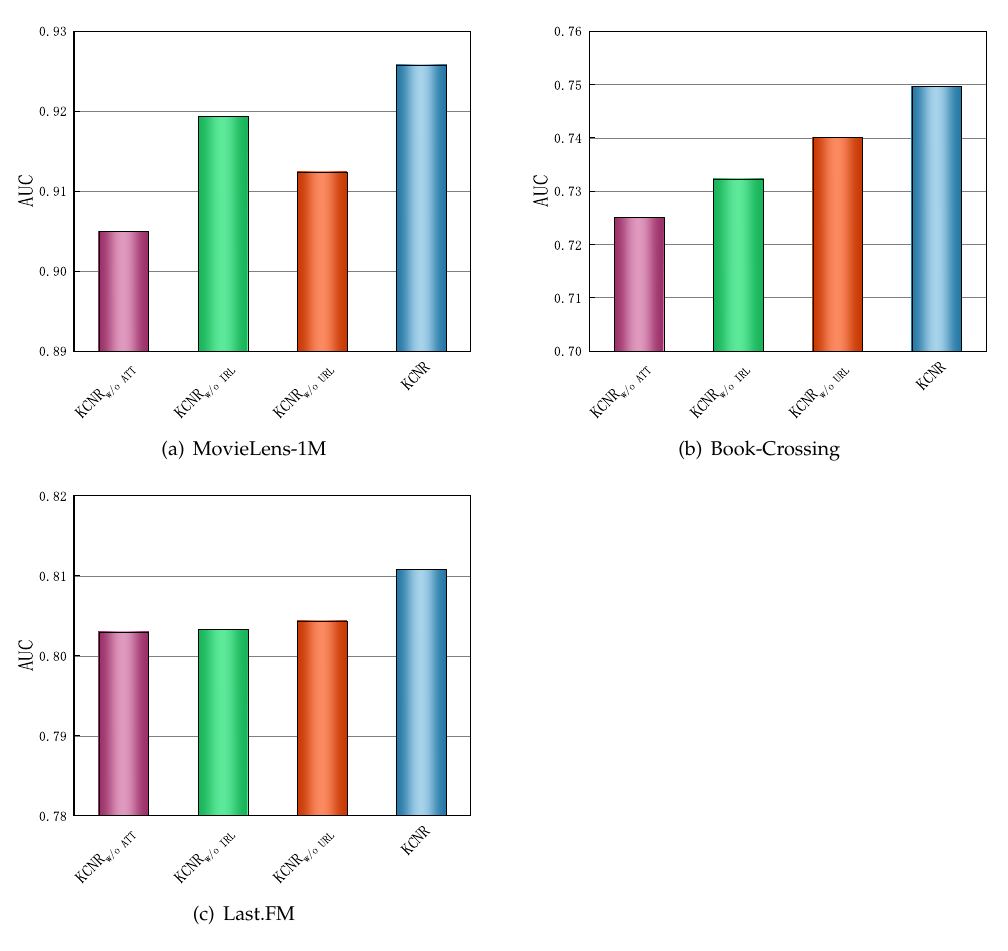
Figure 6. AUC results for different modules of